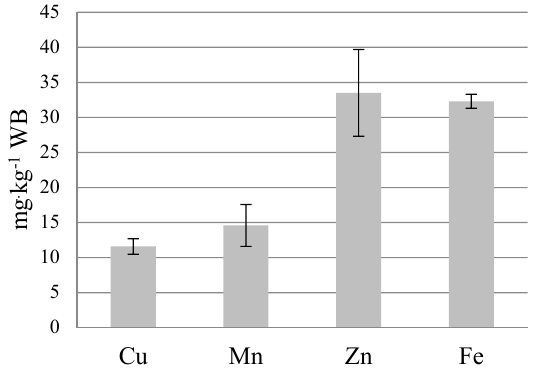
Figure 5. Micronutrients content in STR from the farm scale bio-refinery. Table 2. Composition of ammonium sulphate (AS) from the farm scale